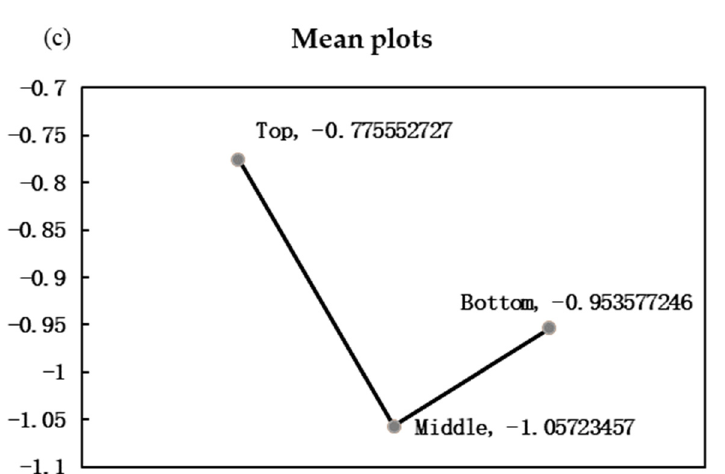
Figure 7. The results of one-way ANOVA analysis and post hoc multiple comparisons: ( a ) test of homogeneity of variances; ( b ) post hoc tests; ( c ) means